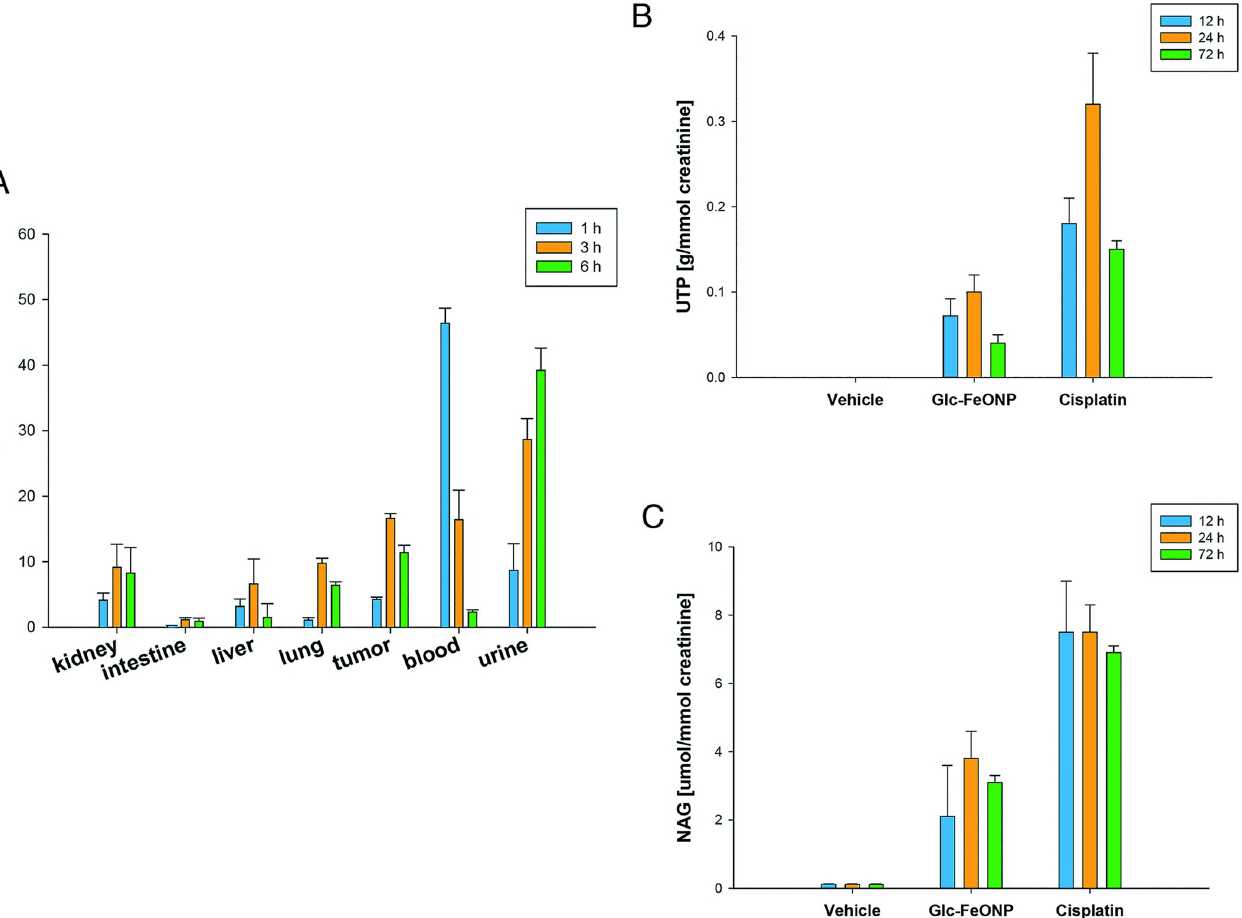
Fig 6. Preliminary in vivo studies. A. Biodistribution studies. Total iron levels determined in the organs or urine of mice treated with Glc-SPIONs after a single i.v. dose (1 mg kg -1 ). B and C. Nephrotoxicity studies. Mice were treated with a single i.v. injection of Glc-SPIONs (1 mg kg -1 ), CDDP(3 mg kg -1 ) or the vehicle solution (saline solution, control) and were then placed in metabolic cages. Urine samples were collected after 12, 24, and 72 h, centrifuged and aliquoted to measure creatinine, uTP (B), and NAG (C). The error bars indicate the SDs of not less than three measurements (p0.01).